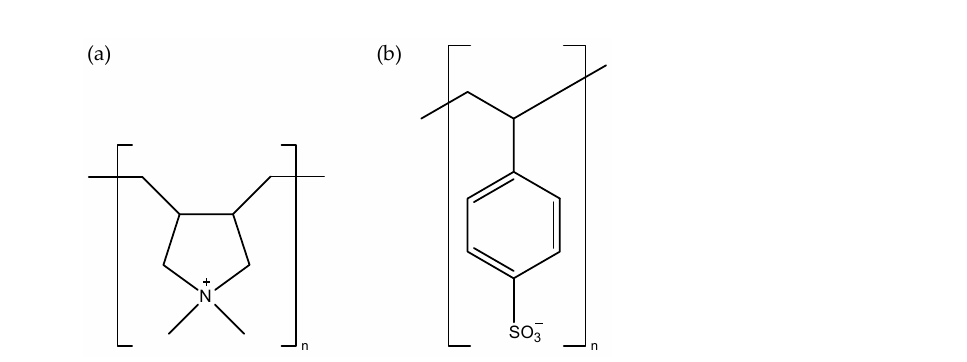
Figure 1. Chemical structure of: ( a ) poly(diallyldimethylammonium) polycation (PDADMA) and ( b ) poly(4-styrenesulfonate) polyanion (PSS).